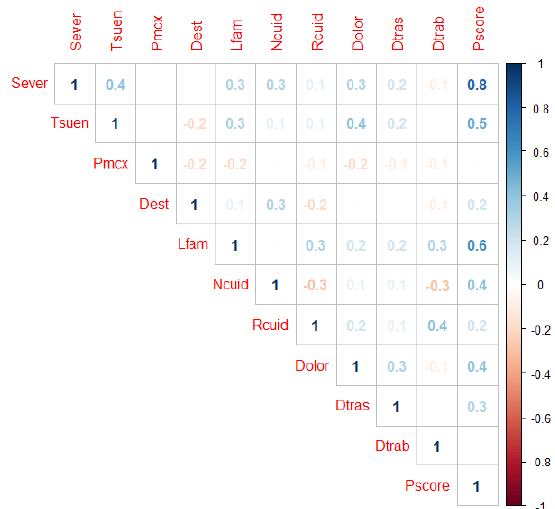
Figure 5. Correlation matrix of variables of the final adjusted model, ( 3 ). Absence of multicollinearity between the predictor variables is